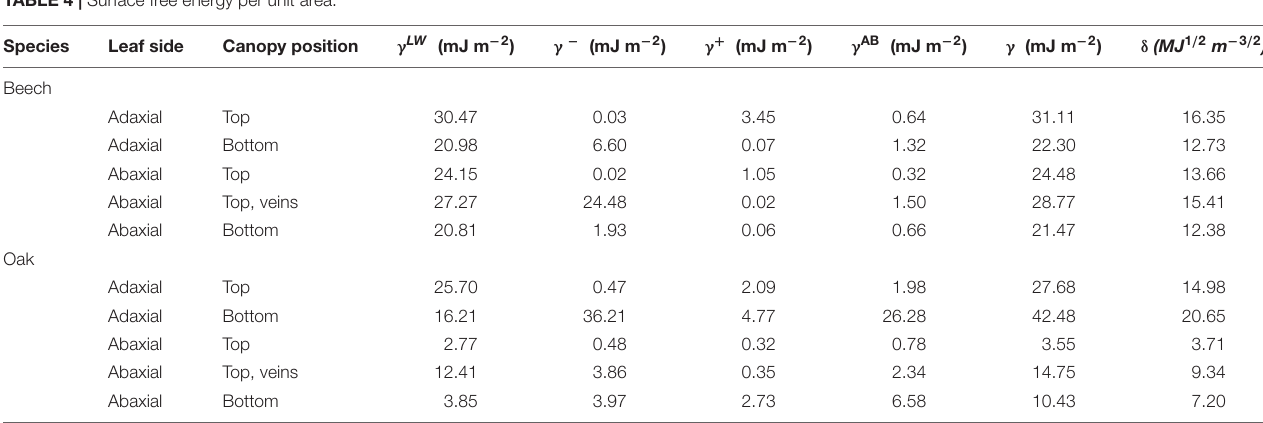
TABLE 4 | Surface free energy per unit area.